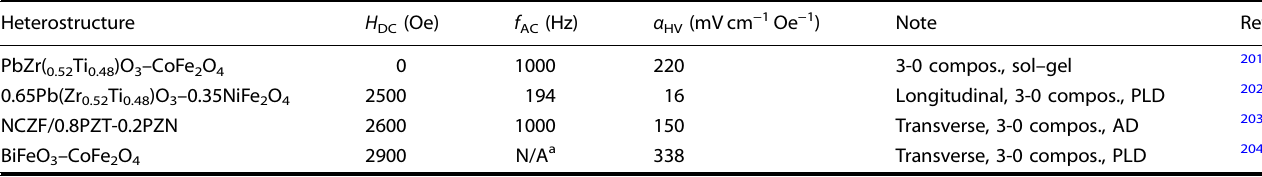
Table 4b. Room-temperature α HV in thin- fi lm particulate magnetoelectric composites (compos.) Heterostructure H DC (Oe)